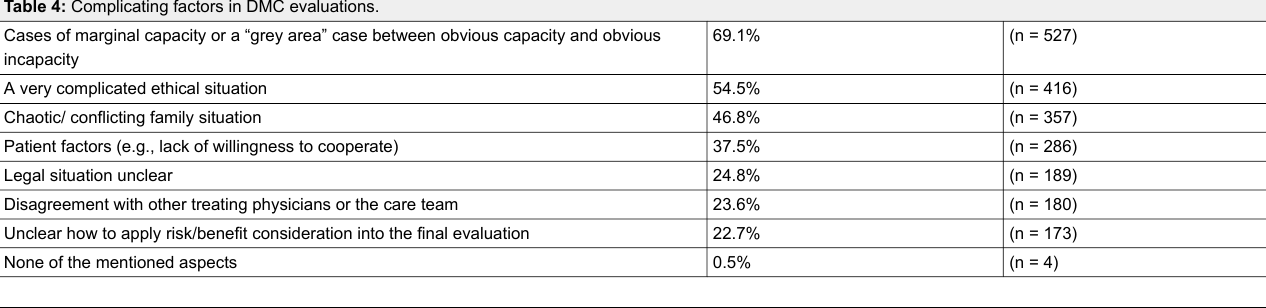
Table 5: Strategies for enhancing DMC: Importance and feasibility in every day practice.